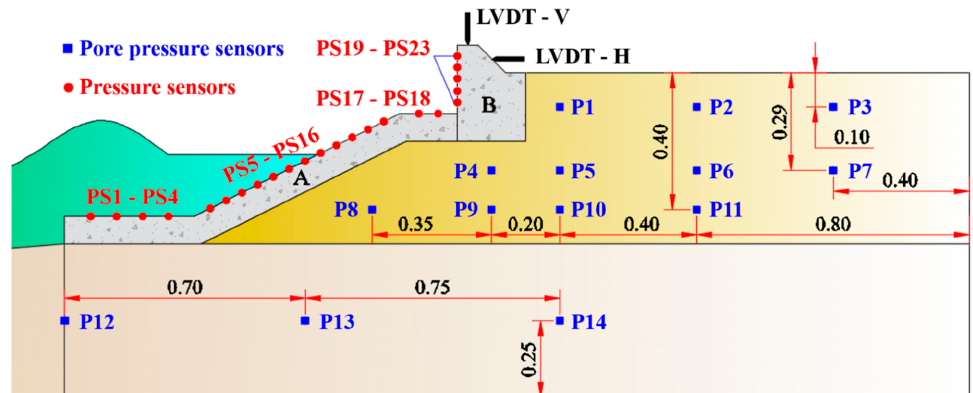
Figure 2. Schematic map of the location of the 14 pore pressure sensors, 23 pressure sensors and 2 displacement sensors (LVDT (Linear Variable Differential Transformer)) in the physical model (unit: m).